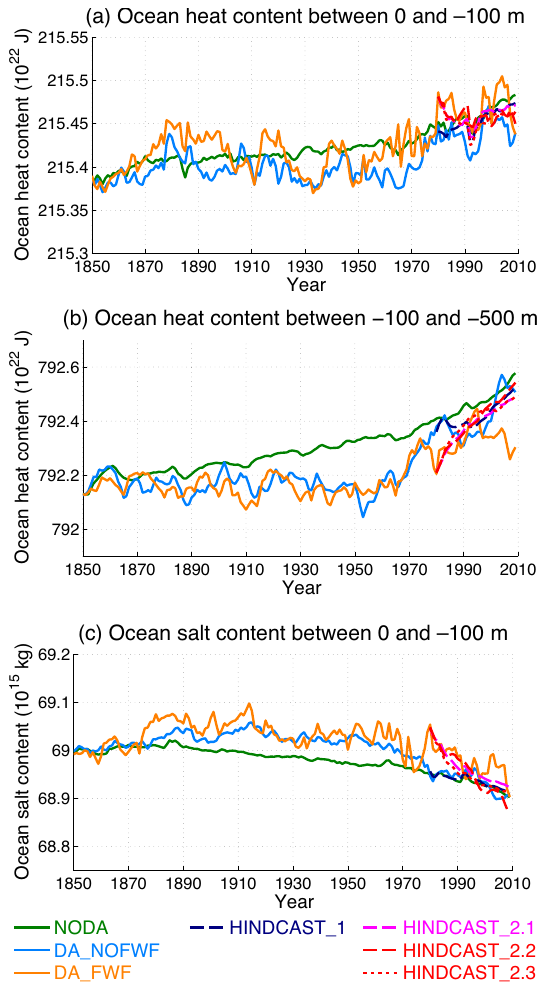
Figure 4. Ensemble mean of yearly mean (a) ocean heat content in the first 100m below the surface, (b) ocean heat content between − 100 and − 500m and (c) ocean salt content in the first 100m below the surface, for the simulations summarised in Table 1. The ocean heat and salt contents are computed south of 60 ◦ S. The ocean heat content is computed against absolute zero.